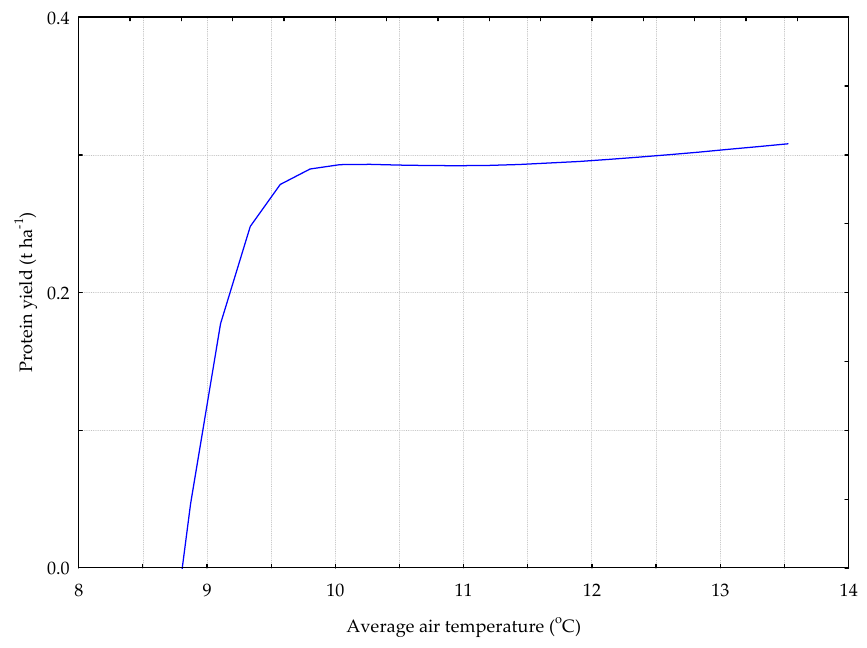
Figure 12. The P_GC model. The response chart for variables T_AV (rank 1) and P_Y.